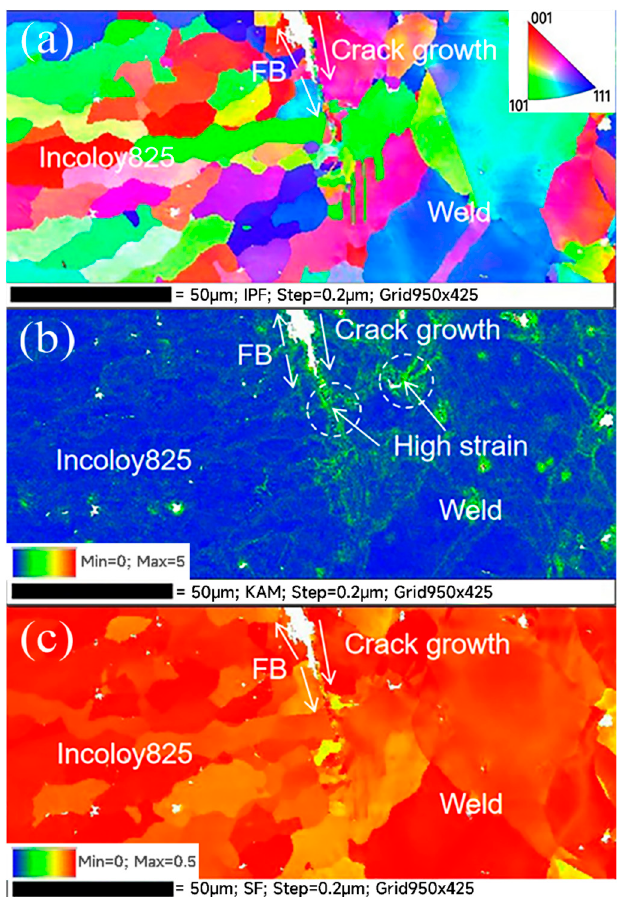
Figure 12. EBSD results of crack tip: ( a ) IPF diagram; ( b ) KAM diagram; ( c ) Schmid factor diagram.